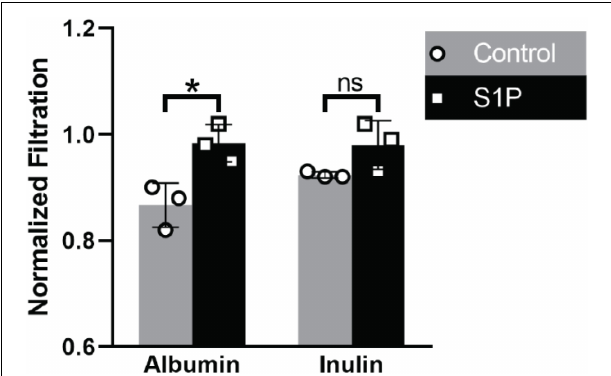
FIGURE 5 | Effect of S1P on Podocyte Filtration: Urinary filtration of albumin was increased as a result of exposure to S1P. Urinary filtration of inulin, which is freely filtered at the GFB, was not significantly altered. Statistical analysis by unpaired t -test ( N = 3, * p <